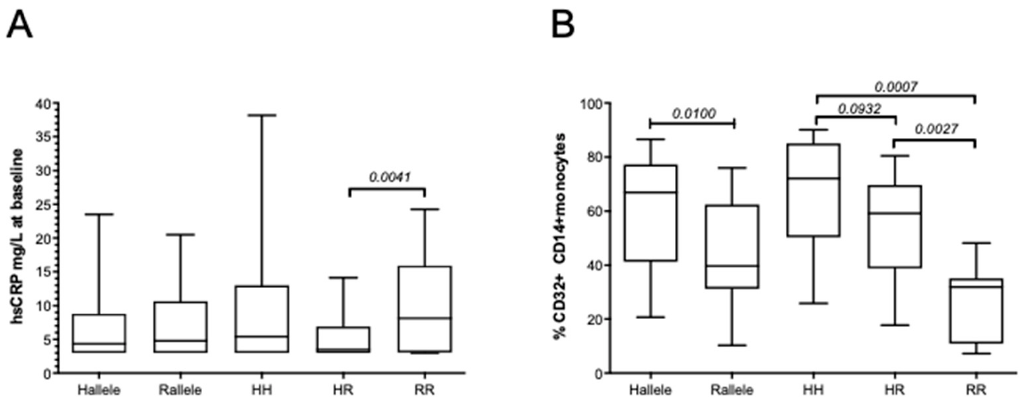
Figure 3. FCGR2A polymorphisms are associated with baseline hsCRP levels and CD32 expression in CD14+ monocytes. ( A ) Baseline hsCRP levels were analyzed in group of patients with ACS according to the presence of the H ( n = 113) or R allelic variants ( n = 102). HH ( n = 43), HR ( n = 70), and RR ( n = 32) refer to the homozygous of heterozygous combinations of FCGR2A allelic variants at the extracellular amino acid position 131: arginine (R) or histidine (H). Groups of RCE+, MACE+, and AHR+ patients were analyzed using Mann–Whitney non-parametric unpaired t tests and compared to the control group of AHR-MACE- patients. p values < 0.05 were reported as significant. hsCRP variables are described as box and whiskers plots representing medians and (10–90%) using GraphPad Prism. Comparison between groups were performed using Mann–Whitney non- parametric unpaired t tests. p values <0.05 were reported as significant. ( B ) The expression of CD32 on circulating CD14+ monocytes (%CD32+CD14+ cells) were analyzed in a subgroup of 58 patients with ACS according to the presence of the H or R allelic variants. HH, HR, and RR refer to the homozygous of heterozygous combinations of FCGR2A allelic variants at the extracellular amino acid position 131: arginine (R) or histidine (H). Proportion of CD32+ monocytes are described using GraphPad Prism as box and whiskers plots representing medians and (10–90%). Comparison between groups were performed using Mann–Whitney non-parametric unpaired t tests. p values <0.05 were reported as significant, and p values ≥ 0.05 and < 0.2 were indicated as a trend for significance.